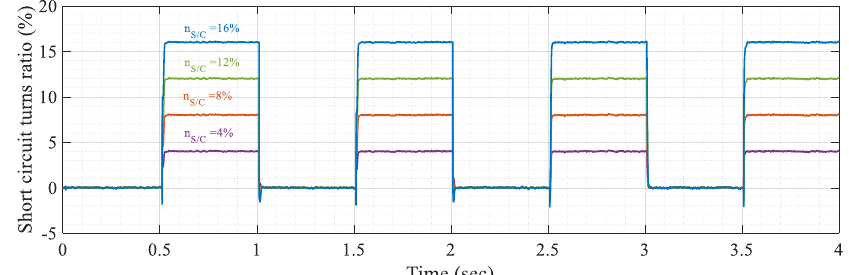
Figure 15. Estimation response in phase A at a frequency of 50 Hz with load variation from 0.75 to 3 A and 7.5 A step.